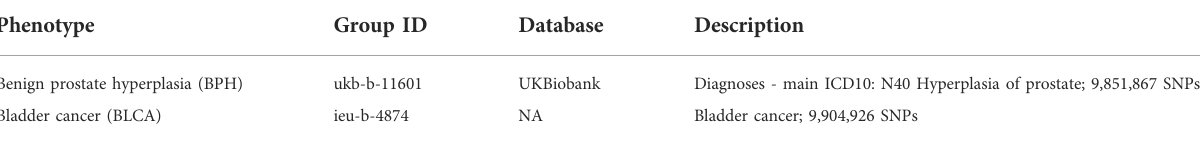
TABLE 1 Basic information of